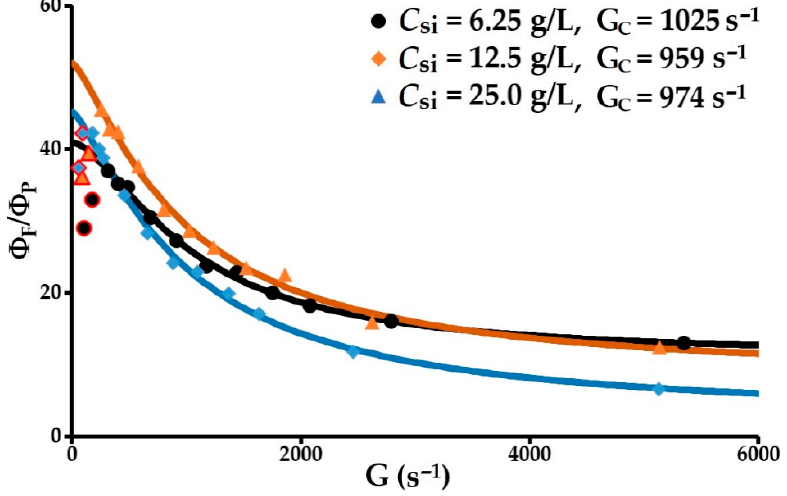
Figure 7. Relative flocs volume fraction vs. the velocity gradient.